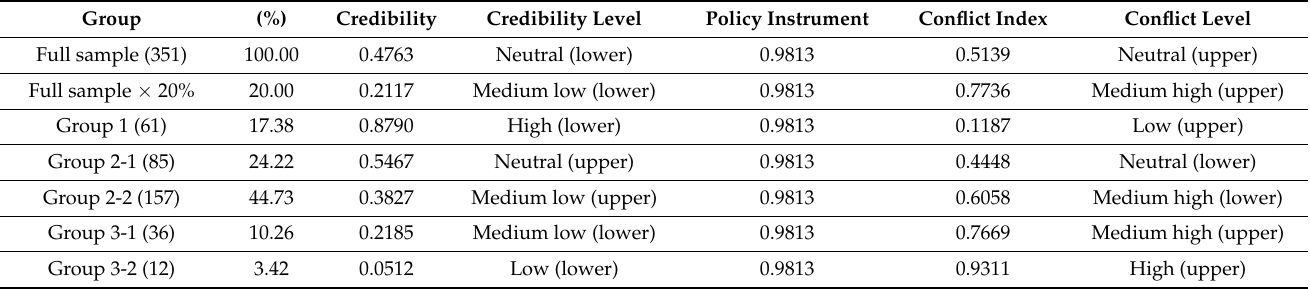
Table 7. Credibility and conflict index in the initial stage of the implementation of the